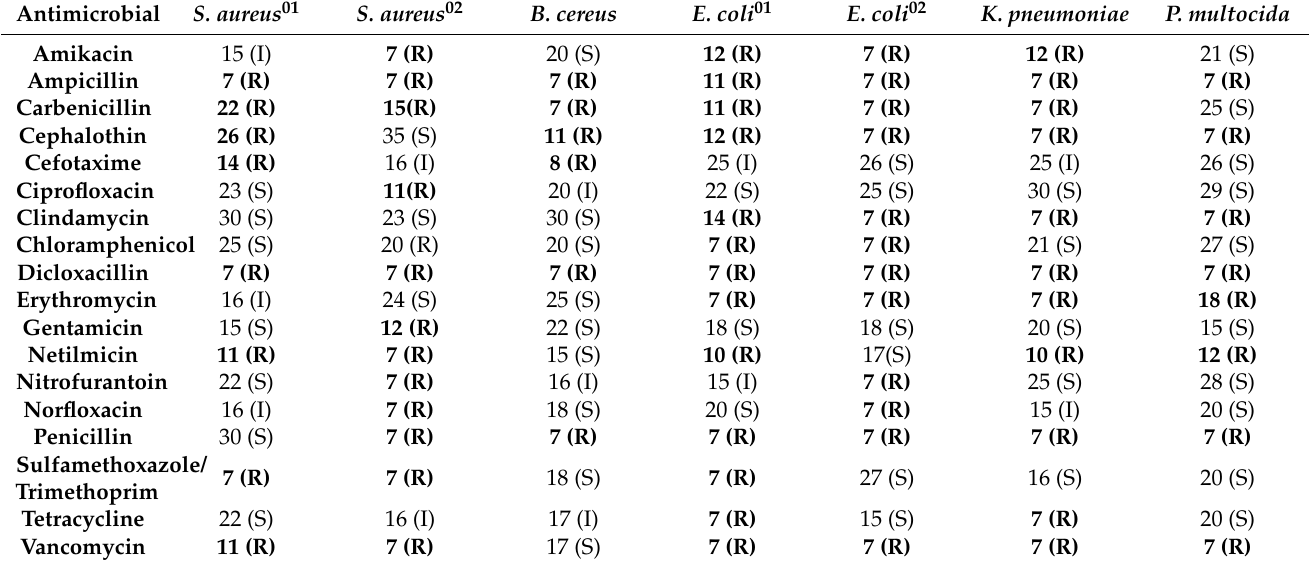
Table 1. Results of inhibition halos (mm) and antimicrobial sensitivity of multidrug-resistant clinical isolates.